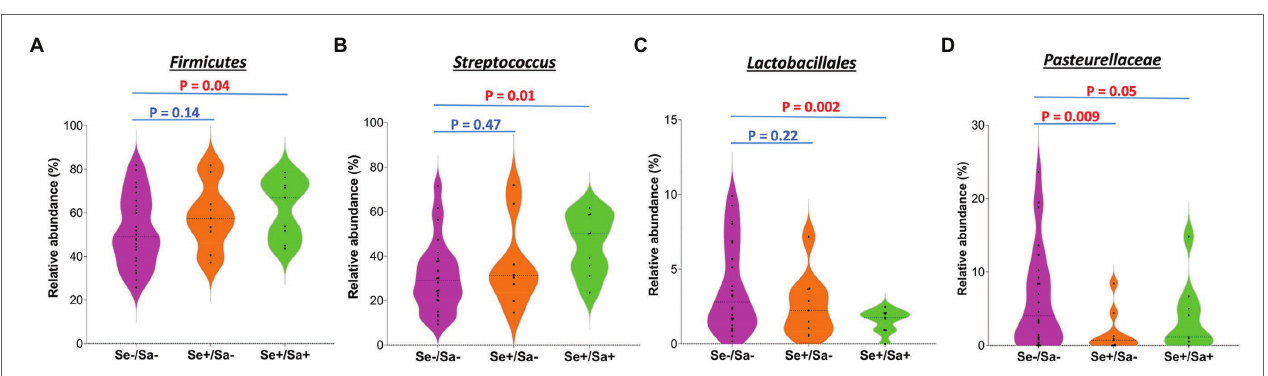
FIGURE 4 | The significantly changed phyla or species in the group of HIV patients with KSHV oral